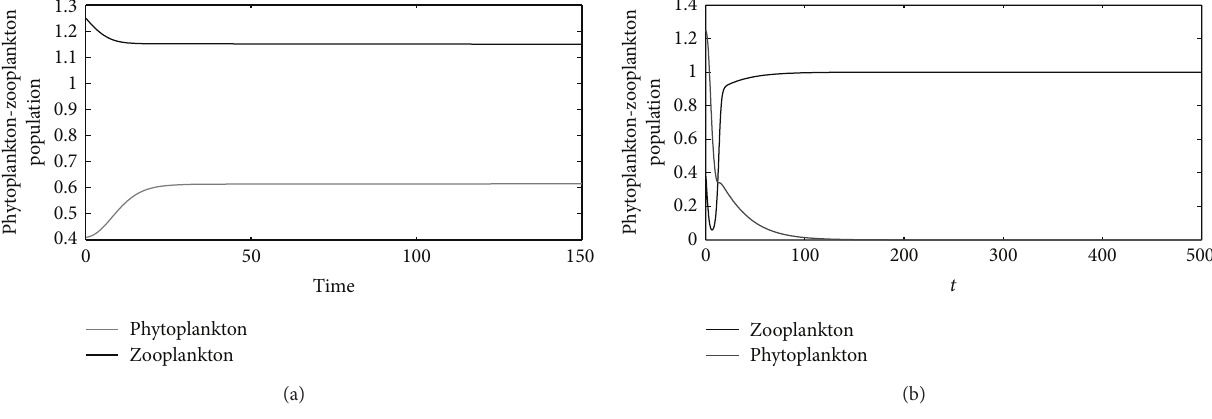
Figure 7: Behavior and phase portrait of system (4). (a) The equilibrium 𝐸 ∗ 2 (0.618, 1.1467) is stable for any 𝜏 > 0 when 𝑝 ∗ 2 > Δ 𝛼 = 0.414 . (b) The equilibrium 𝐸 ∗ 2 (0.4633, 0.5207) is unstable for any 𝜏 > 0 when 𝑝 ∗ 2 < Δ 𝛼 = 0.414 . The initial value is (𝜙(0),𝜑(0)) = (0.41, 1.25)